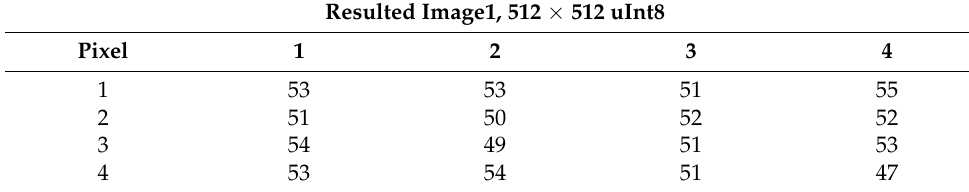
Table 3. Modified DC